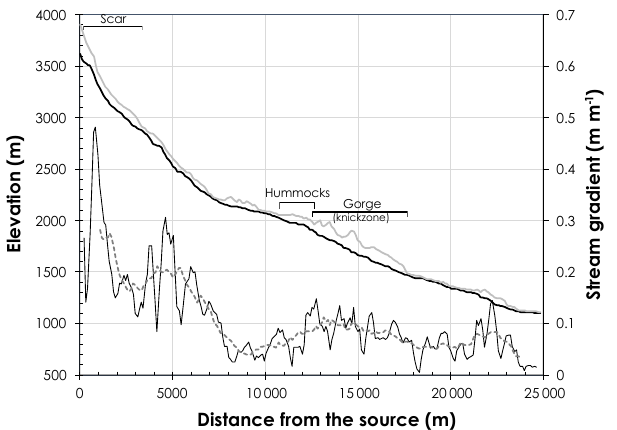
Figure 8. Longitudinal profile and stream gradient along the main course of the DAD. The black solid line in the upper side (left y axis) indicates the longitudinal profile along the main course whose location is shown in Fig. 1, while the solid gray line indicates the maximum elevation within the 500m range across the main course. The thin black line on the lower side (right y axis) is the stream gradient averaged for the 400m zone upstream and downstream for each sampling point, whereas the dashed gray line is that averaged for the 2000m zone.